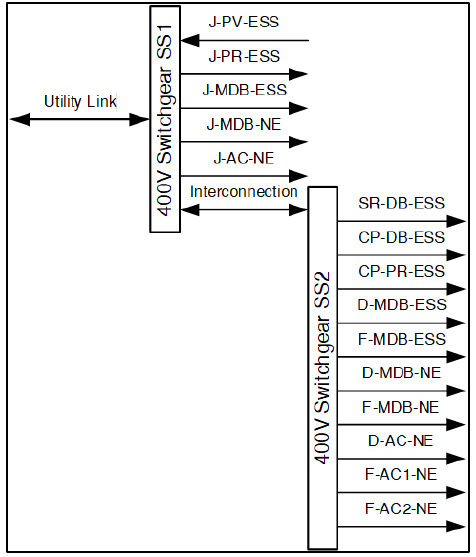
Figure 3. Basic setup for feeders being monitored